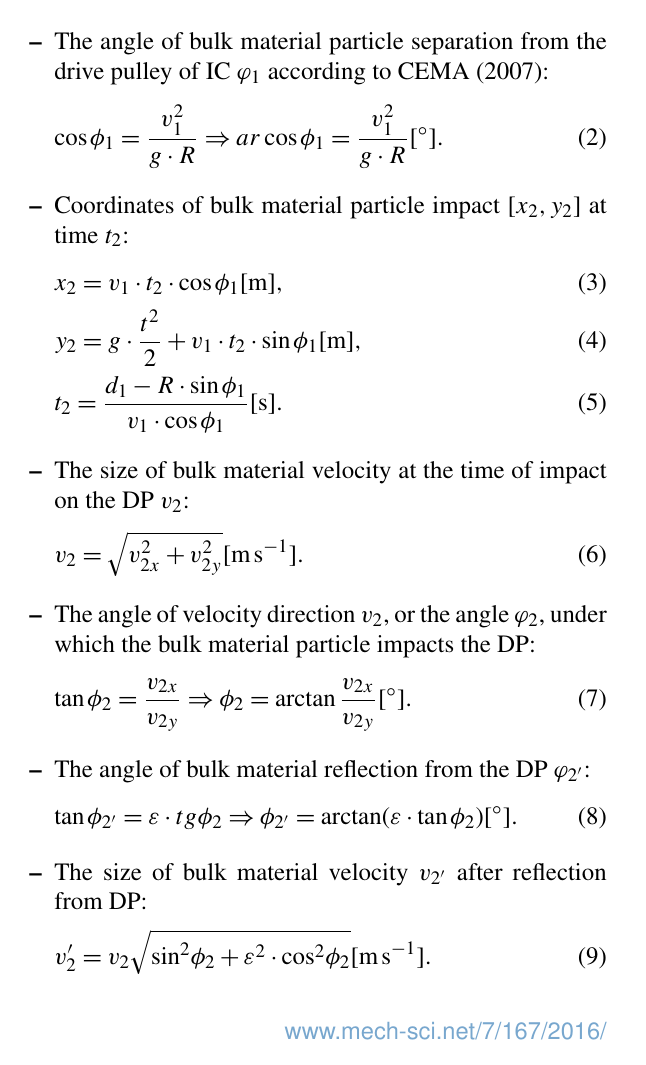
Figure 4. Impact force at the moment of the material particle im- pacting the damping plate and immediately after the